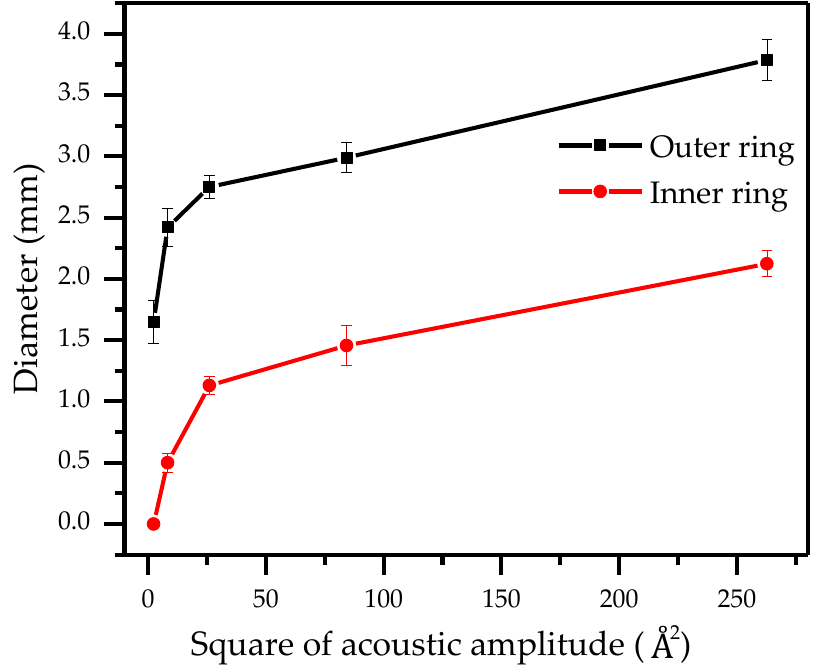
Figure 8. The correlation between the inner and outer diameters of the particle ring and the square of the acoustic